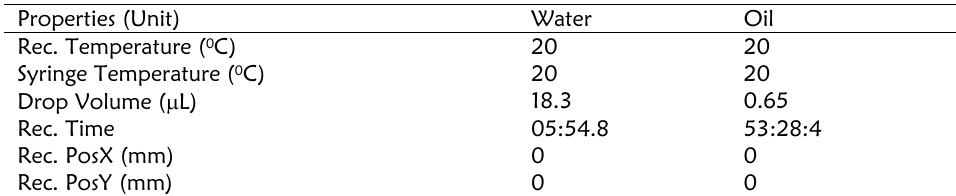
Table 1: Selected condition during contact angle testing